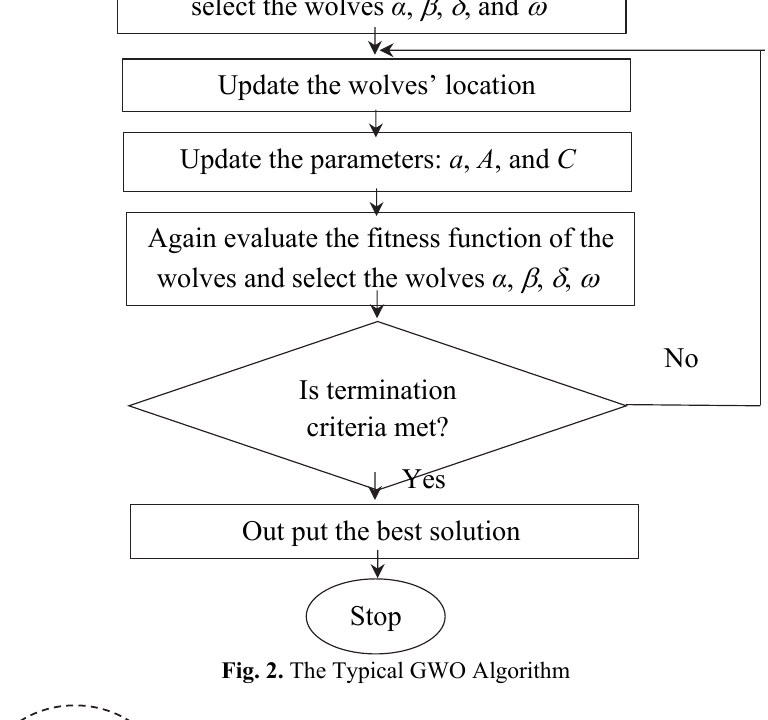
Fig. 2. The Typical GWO Algorithm